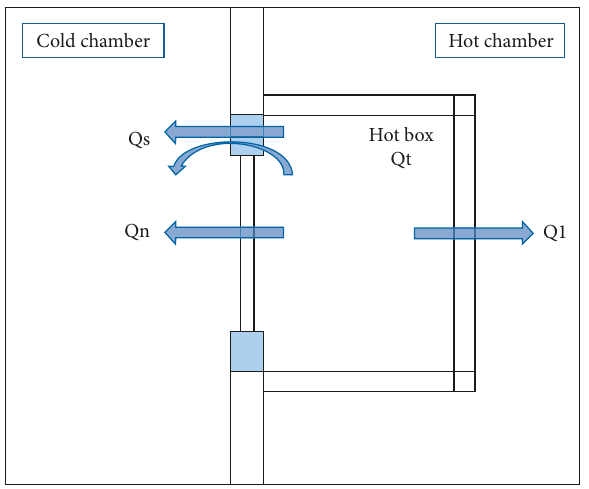
Figure 1: Measurement theory of thermal